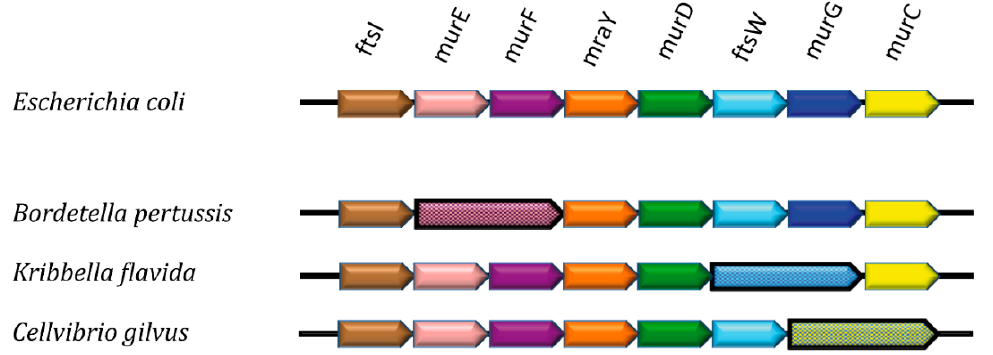
Figure 3. Schematic representation of a section of the dcw (division and cell wall) cluster in different bacterial genomes. Adjacent arrows represent contiguous genes involved in cell wall synthesis and division. In a number of species, adjacent genes are fused, such as in numerous strains of B. pertussis (murE/murF), and in the actinomycetes K. flavida (ftsW/murG) and C. gilvus (murG/murC).